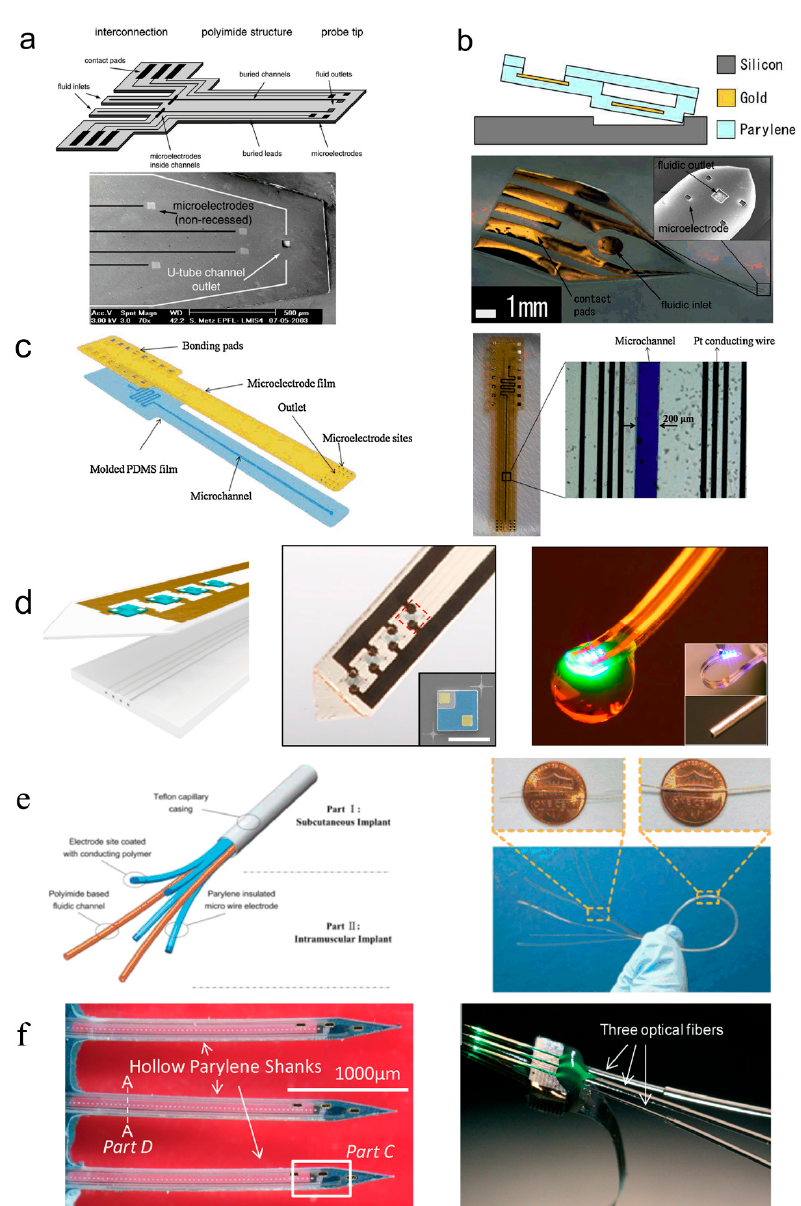
Figure 5. Research progress of flexible MEMS microelectrodes with fluidic channels for neural